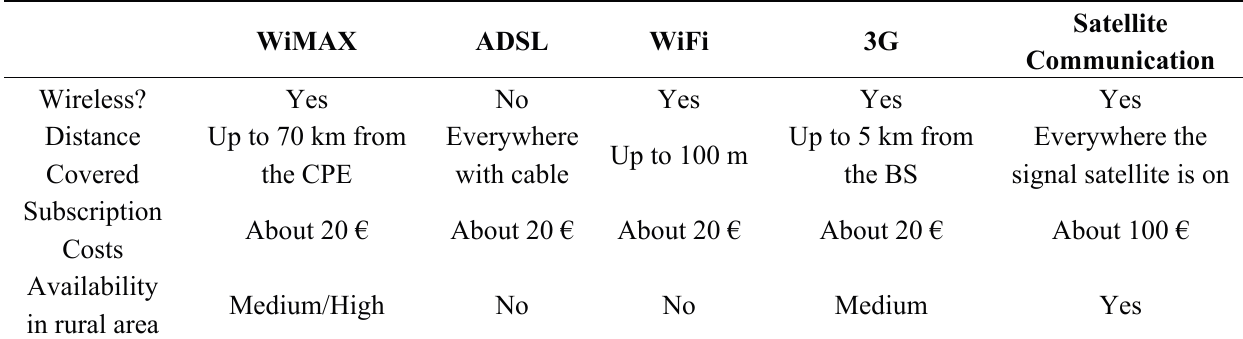
Table 3. WiMAX vs. other communication